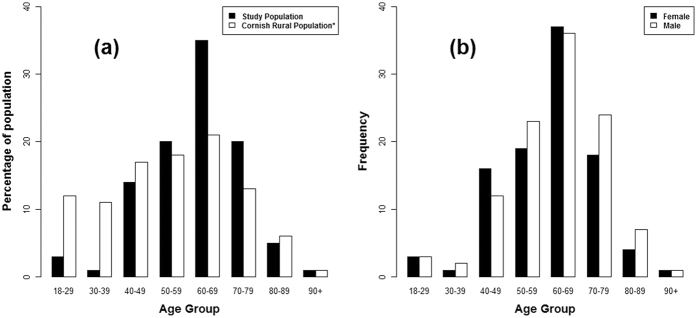
Study group age and gender distribution.While population risk assessment is not the focus of this aspect of the study, it is noted for future reference that the present sample is not wholly representative of the underlying population of rural Cornwall. *Office for National Statistics (ONS) Rural-urban classification 2011 (RUC11) was used to determine the underlying population (see supplementary information). Adapted from data from the Office for National Statistics licensed under the Open Government Licence v.3.0.